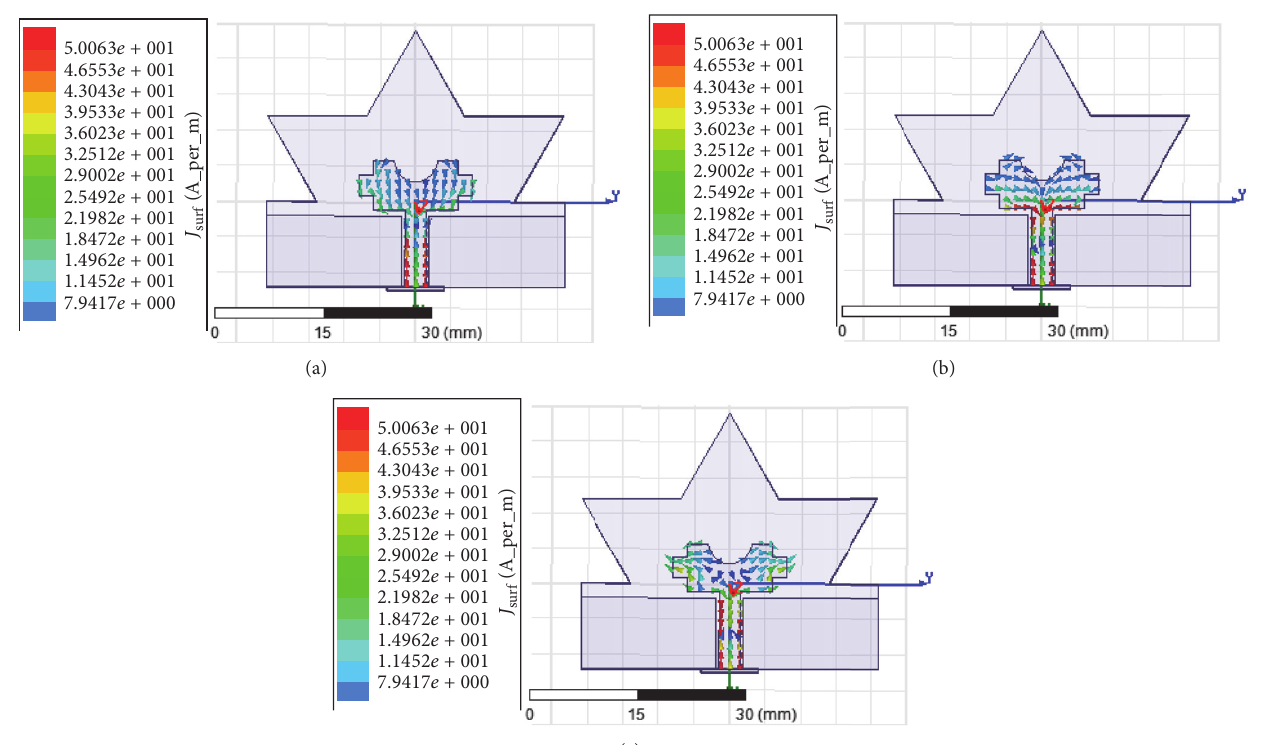
Figure 4: The surface current distribution on the proposed defected substrate wideband antenna at (a) 5.48 GHz, (b) 8.03 GHz, and (c) 12.01GHz.